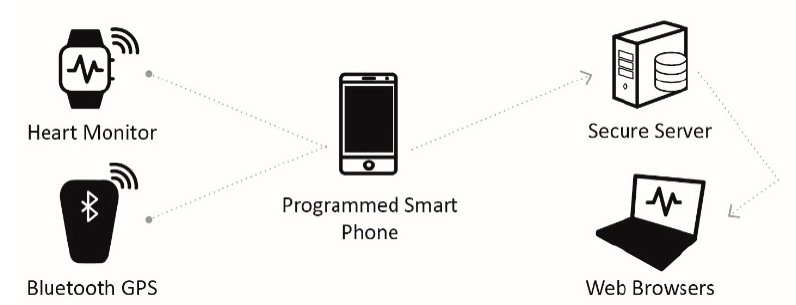
Figure 3. Components of the remote monitoring system. (Adapted from Worringham et al. [29]).